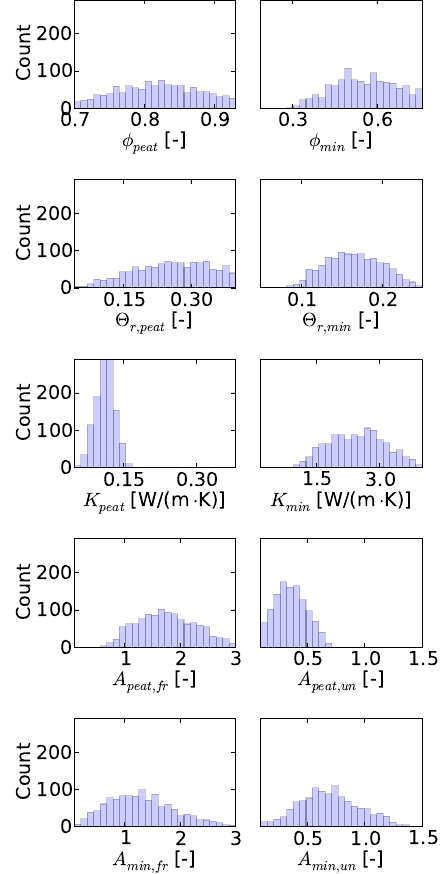
Figure 1. Histograms of calibration-constrained hydrothermal soil parameter combinations obtained by NSMC sampling